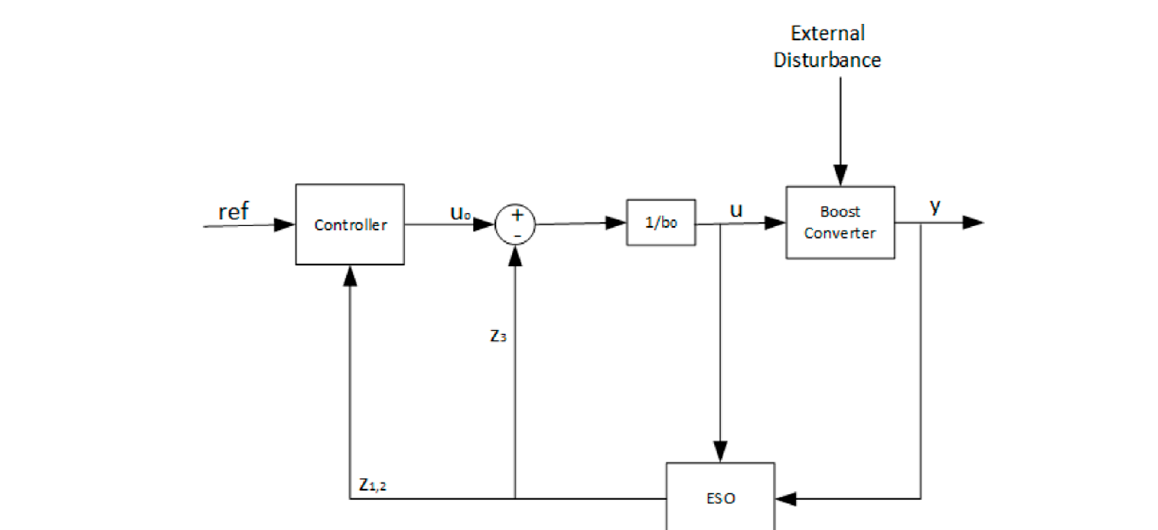
FIGURE 12 Structure of the ADRC.